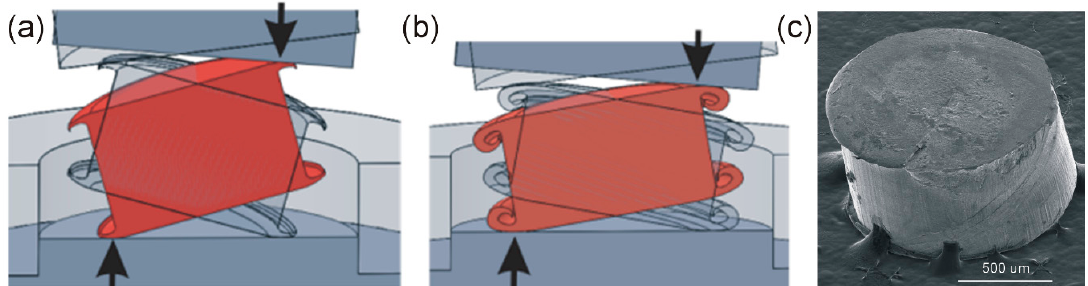
Figure 12. ( a , b ) The theoretical course of the process without the impact of die-cavity. ( c ) An example result of simple ultrasonic assisted micro-upsetting—previous investigation.